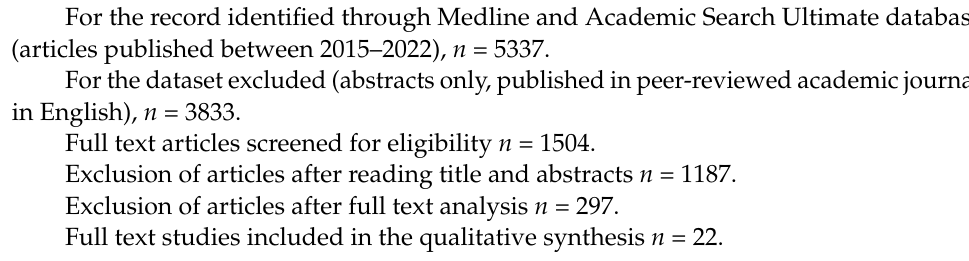
Table 2. Overview of the results—facilitators. Facilitating factors for eHealth and